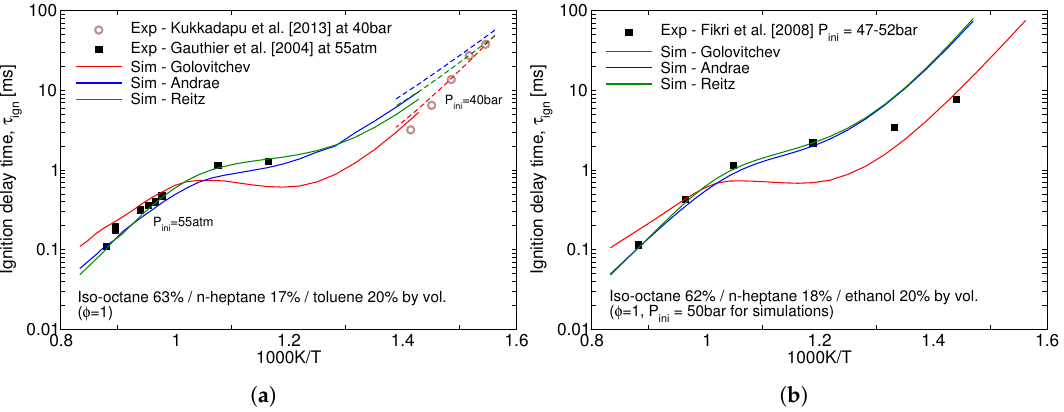
Figure 2. Predicted vs. measured ignition delay times of the ( a ) Gauthier TRF-A and ( b ) an ethanol-containing gasoline surrogate by Fikri et al.